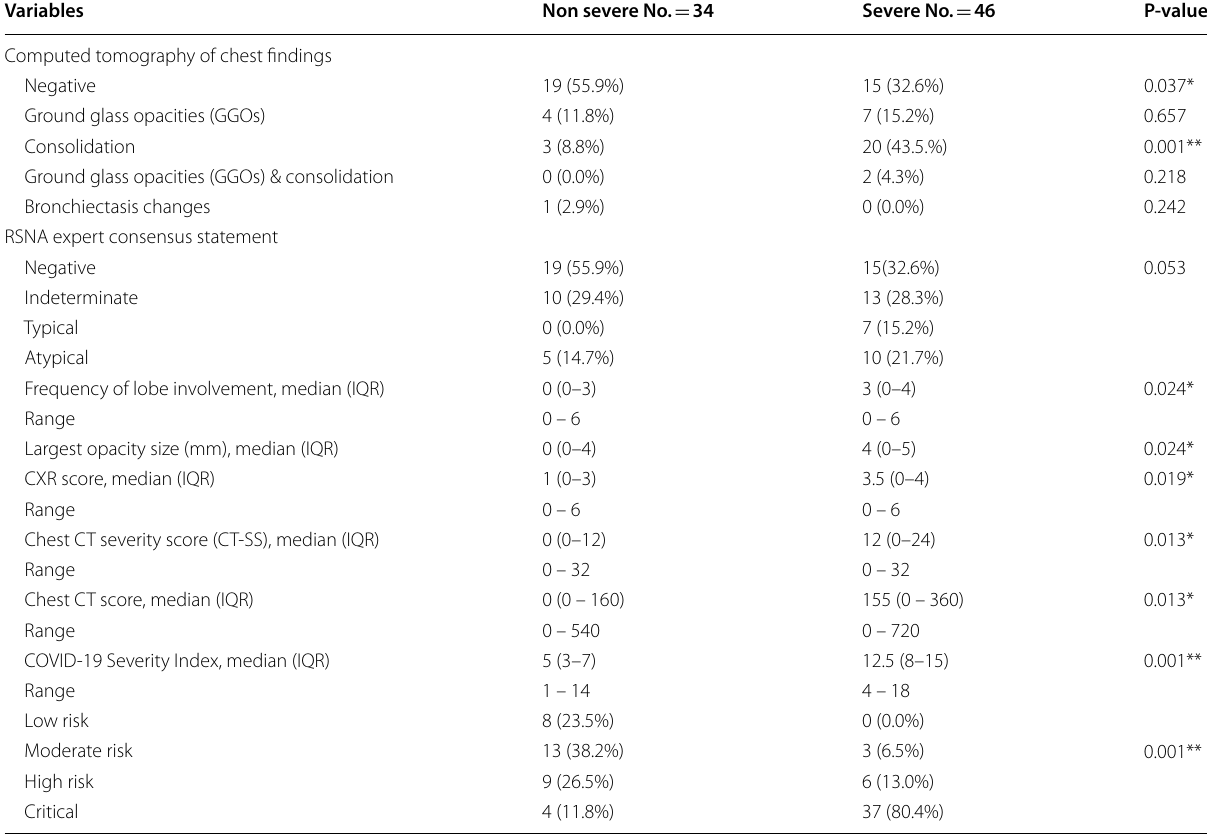
Table 3 Radiological findings among the studied patients’